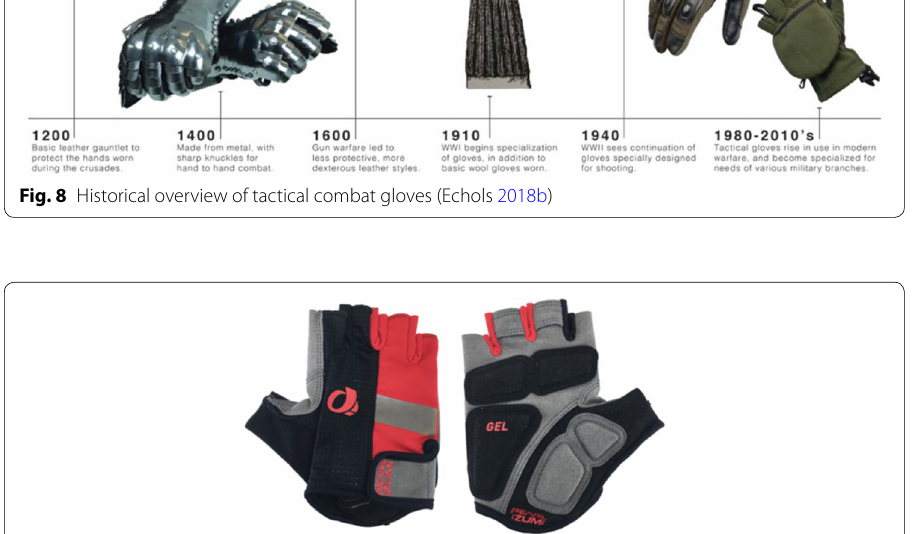
Fig. 9 State-of-the-art cycling glove (Sokolowski and Hoegsted